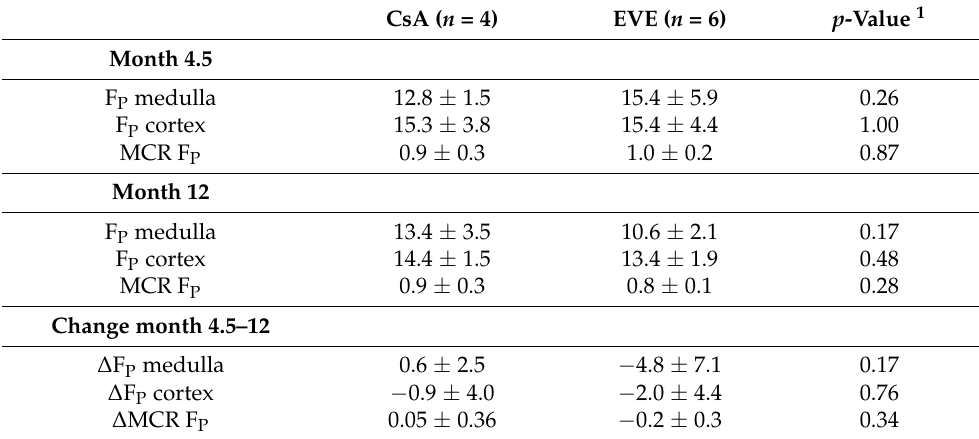
Table 4. DWI-derived perfusion fraction according to medication group and